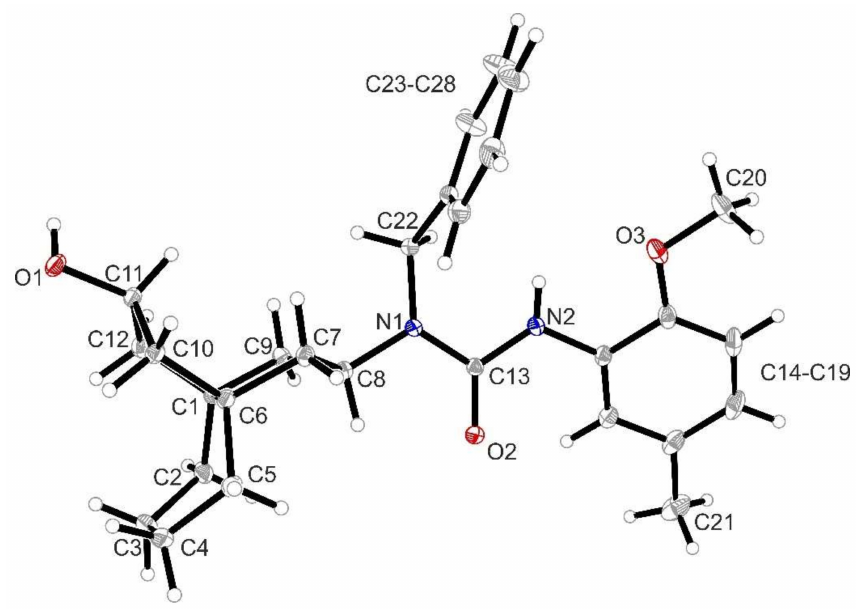
Figure 8. X-ray crystal structure of N -benzyl urea anti , syn - 22 . Thermal ellipsoids are set at 15% probability. Selected bond lengths: C1–C6 = 1.590(2) Å; C1–C2 = 1.535(3) Å; C1–C9 = 1.538(2) Å; C1–C12 = 1.544(2) Å. CCDC number: